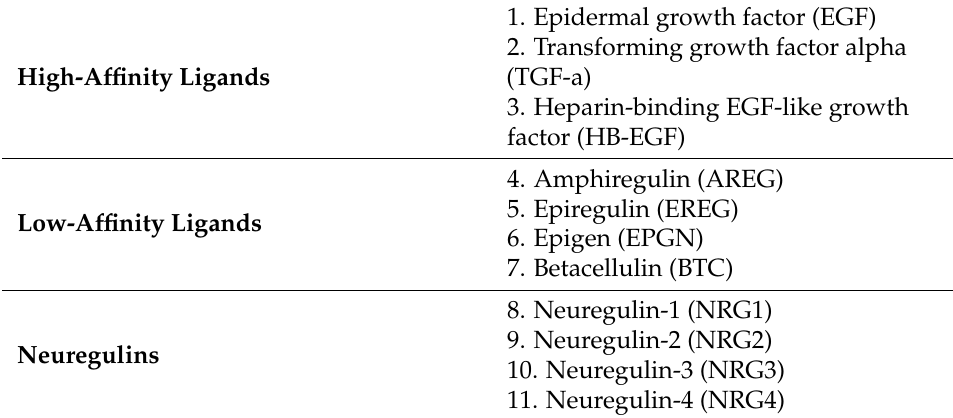
Table 1. EGFR Ligands and their